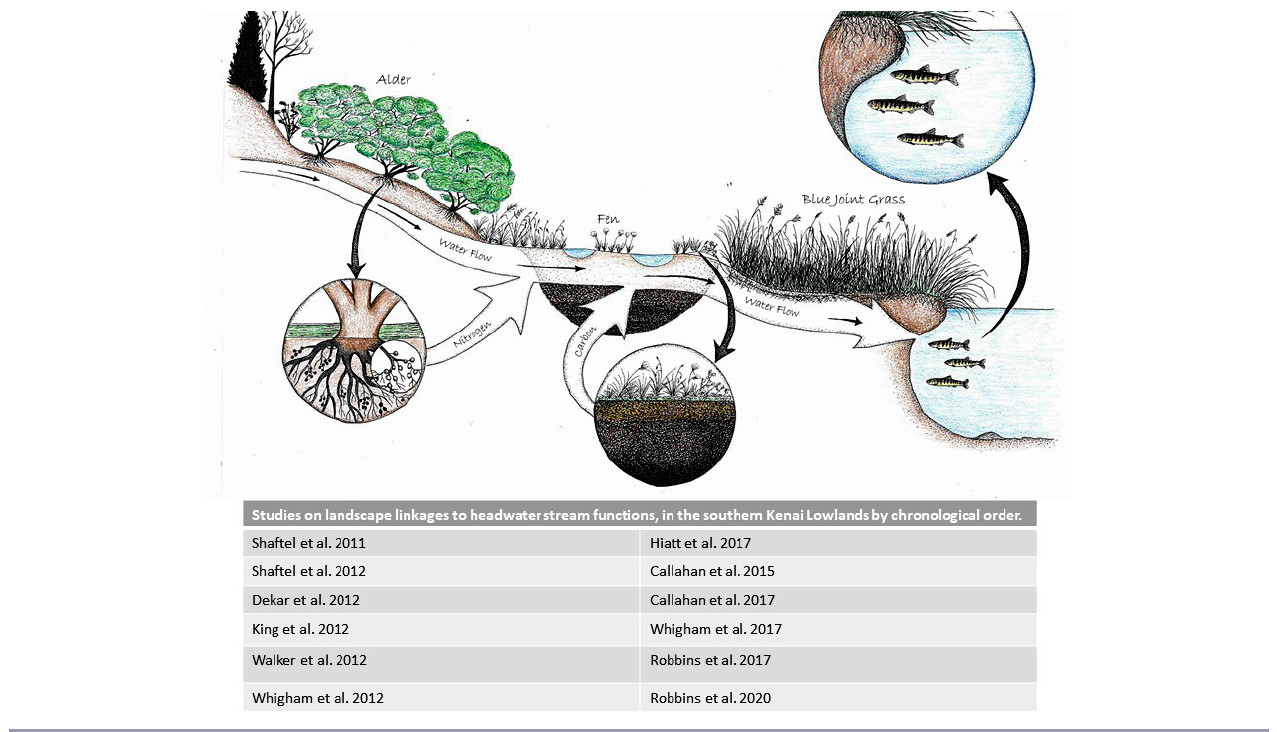
Fig. 3. Conceptualized drawing of the connections between surrounding landscapes and headwater stream juvenile salmon habitat. The drawing provides a visual summary of the scientific concepts and is useful for outreach and communications. Key references from State of Alaska Salmon and People Kenai Lowlands Workgroup studies are also